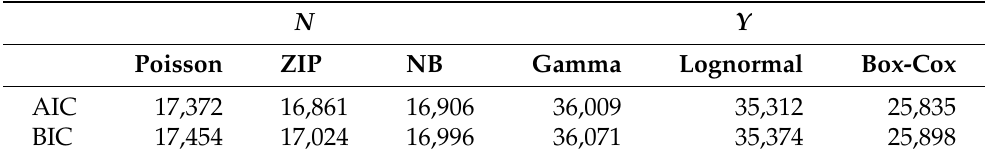
Table 2. AIC and BIC for Generalized Linear Models (GLMs) for frequency ( N ) and severity ( Y )